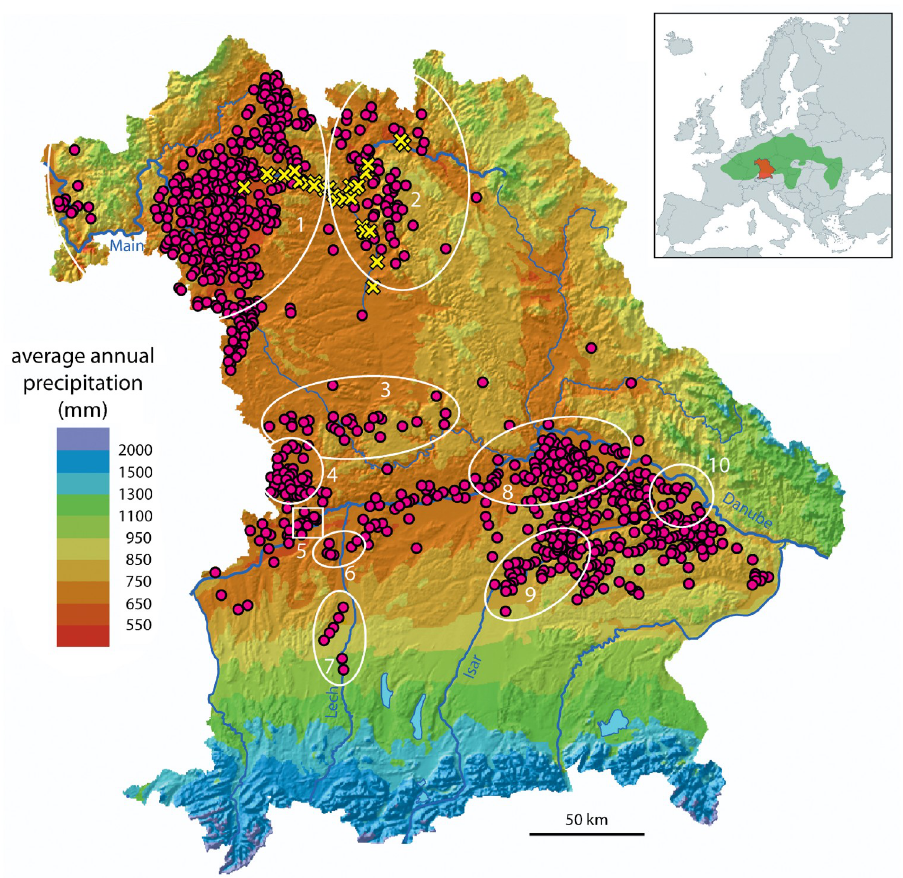
Fig 1. Distribution of LBK settlements (red dots) in relation to recent average annual precipitation in Bavaria. Regions analyzed concerning the settlement dynamic during LBK and early Middle Neolithic: 1 Lower Franconia, 2 Upper Franconia, 3 south-central Franconia, 4 Ries, 5 upper Danube/Ho¨chsta¨dt region, 6 Lech estuary, 7 middle Lech, 8 Danube/Regensburg region, 9 middle Isar, 10 Isar estuary. Sites where the analyzed oaks were found are indicated by yellow crosses. The small map indicates the entire distribution of the LBK in Europe (green) and the position of Bavaria (red).